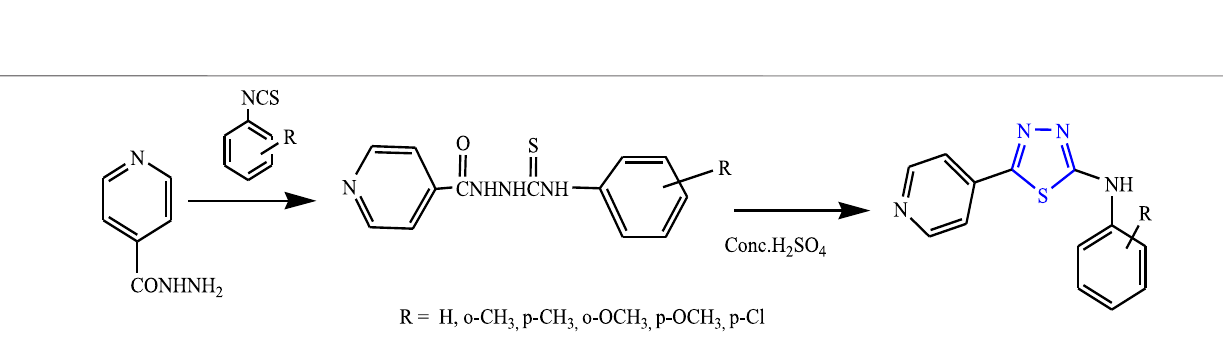
FIGURE 27 | Systematic scheme for synthesizing amine-1,3,4-thiadiazole analog.